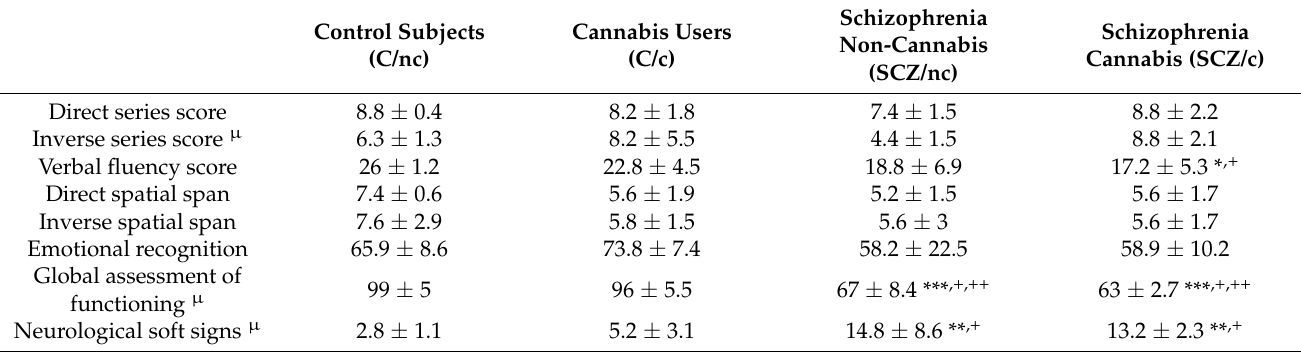
Table 2. Neuropsychological and clinical data of the different